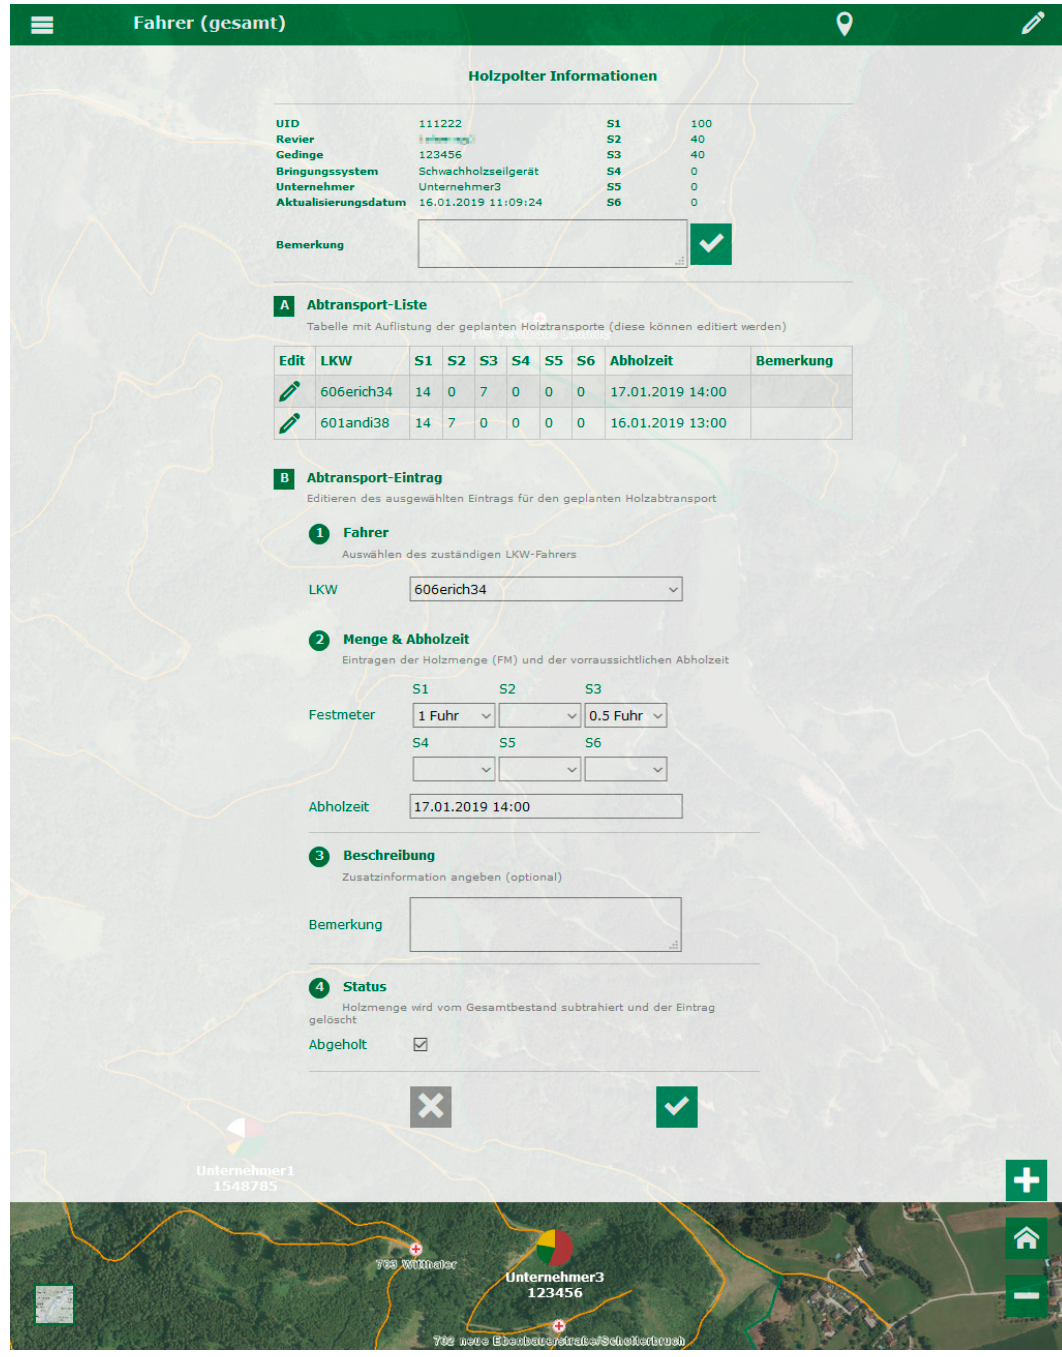
Figure 8. The “Driver app” is used for managing deliveries and here, the planned deliveries for a specific woodpile storage location are shown.